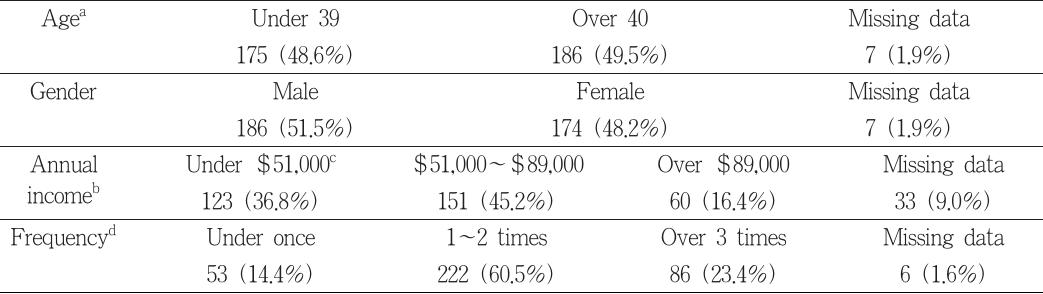
<Table 1> The Summary of Sample